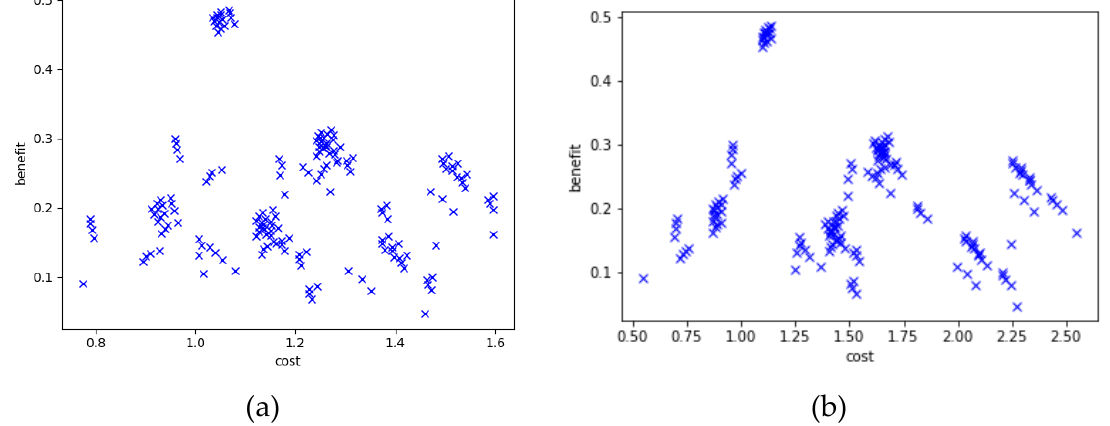
Figure 4. Pre-defined scheme 1 (achieve a nearly zero energy district) ( a ) and pre-defined scheme 1A (achieve a nearly zero energy district + economic aspects) ( b ).